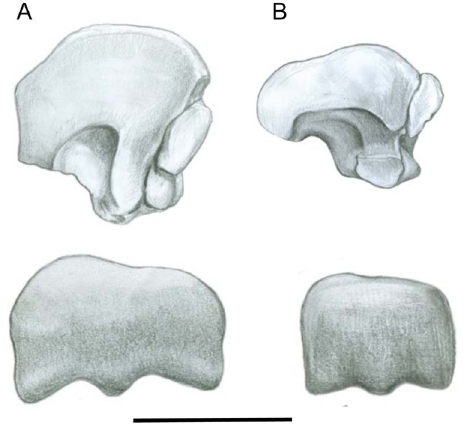
Figure 7. Fourth metatarsal. (A) Sthenurus stirlingi (AMNH 117496). (B) Macropus giganteus (AMNH 2390 [reversed]). All left side: upper = proximal articular view; lower = distal articular view (plantar side downwards). Scale bar =2 cm.